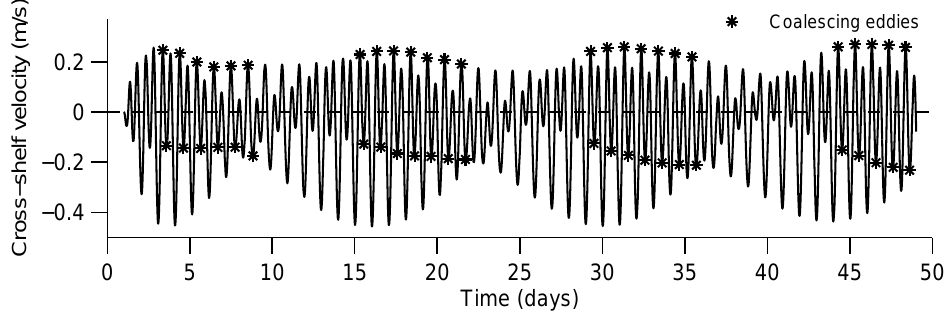
Fig. 6. Timing of coalescing eddy generation for whole model run. Eddies are advected into the coalescing zone during strong floods followed by weak ebbs.